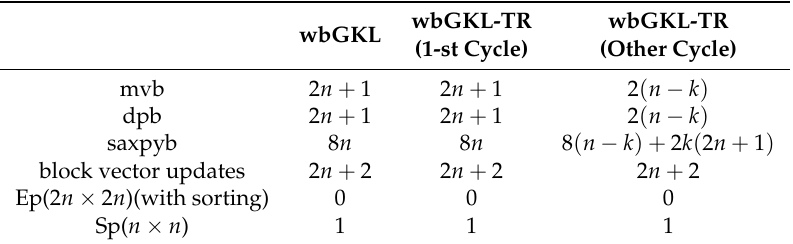
Table 1. Main computational costs per cycle wbGKL and wbGKL-TR.